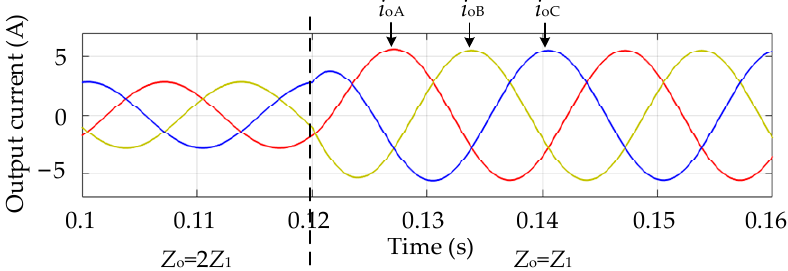
Figure 20. The output current of each phase during a resistive–inductive load transient.